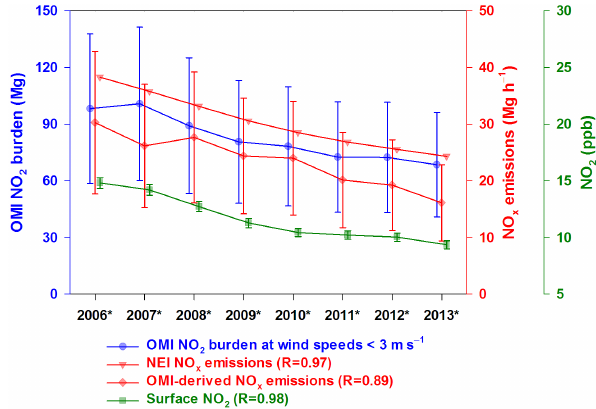
Figure 5. Interannual trends of NEI NO x emissions, the OMI- derived summertime (April–September) NO x emissions, the OMI- observed summertime NO 2 burdens at low-wind-speed (<3ms − 1 ) conditions, and the average summertime NO 2 concentrations at 13:00–14:00LT in Chicago during 2006*–2013*. Error bars ex- press the ± 1 SD of the annually estimated results. R values shown are the correlation coefficients with the OMI-observed NO 2 bur-